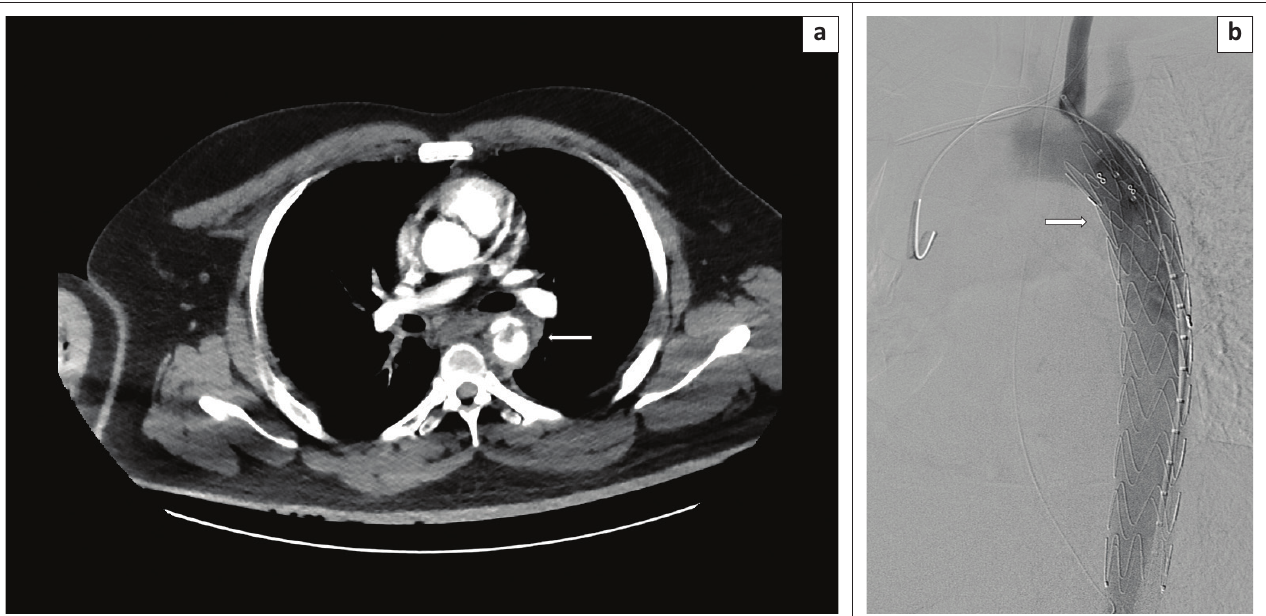
FIGURE 4: (a) A 45-year-old male jumped from the fourth floor and sustained multiple injuries. Initial computed tomography angiography revealed a traumatic type 2 aortic injury with an intimal flap, thrombus and false aneurysm (arrow). (b) Sagittal oblique digital subtraction angiogram image with the stent in place (arrow). No complications